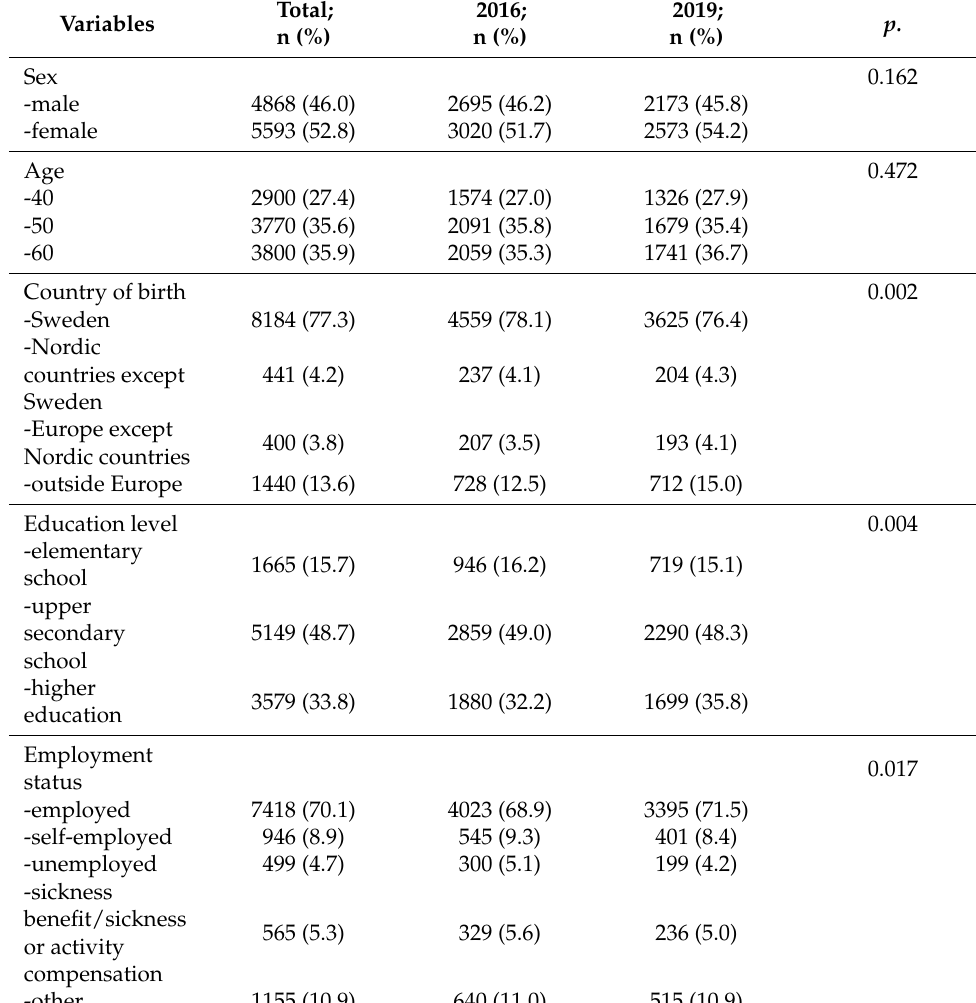
Table 1. Demographic data. Frequencies for the total sample (N = 10,583) and for sub-samples (2016 n = 5837; 2019 n = 4746). Also presented are p -values for Chi 2 tests that were used to check for differences between the two different samples from 2016 and 2019. Missing data are not